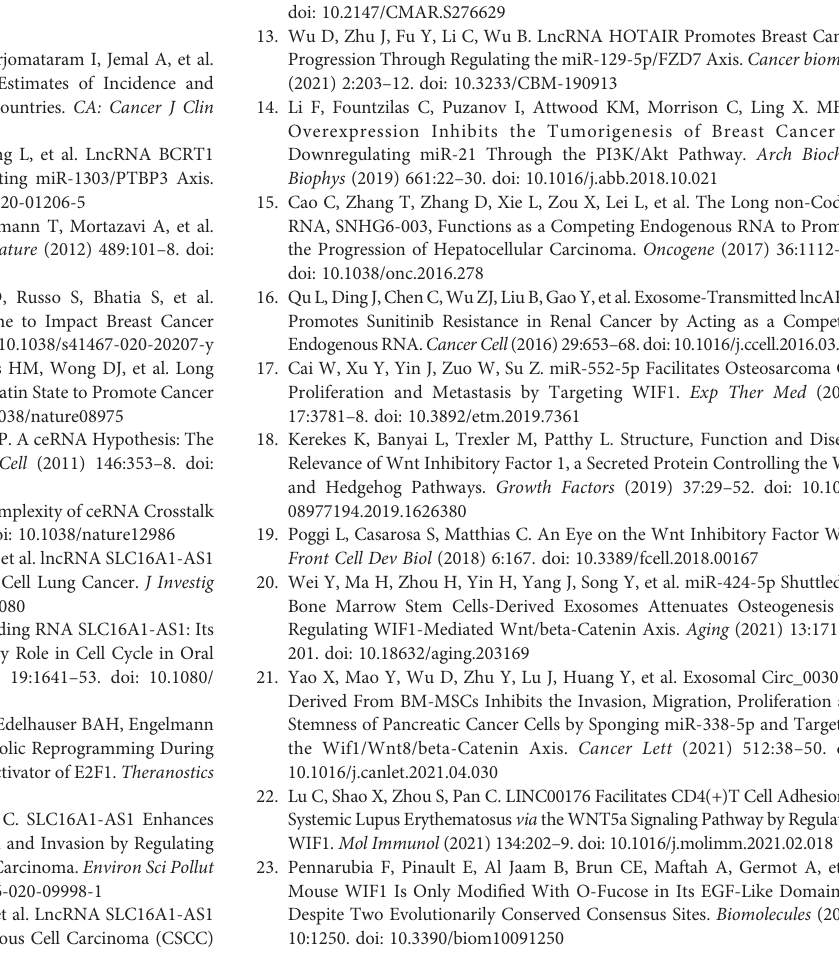
Supplementary Figure 1 | Expressions of miR194 and SOCS2 after SLC16A1- AS1 overexpression in BC cells by qRT-PCR